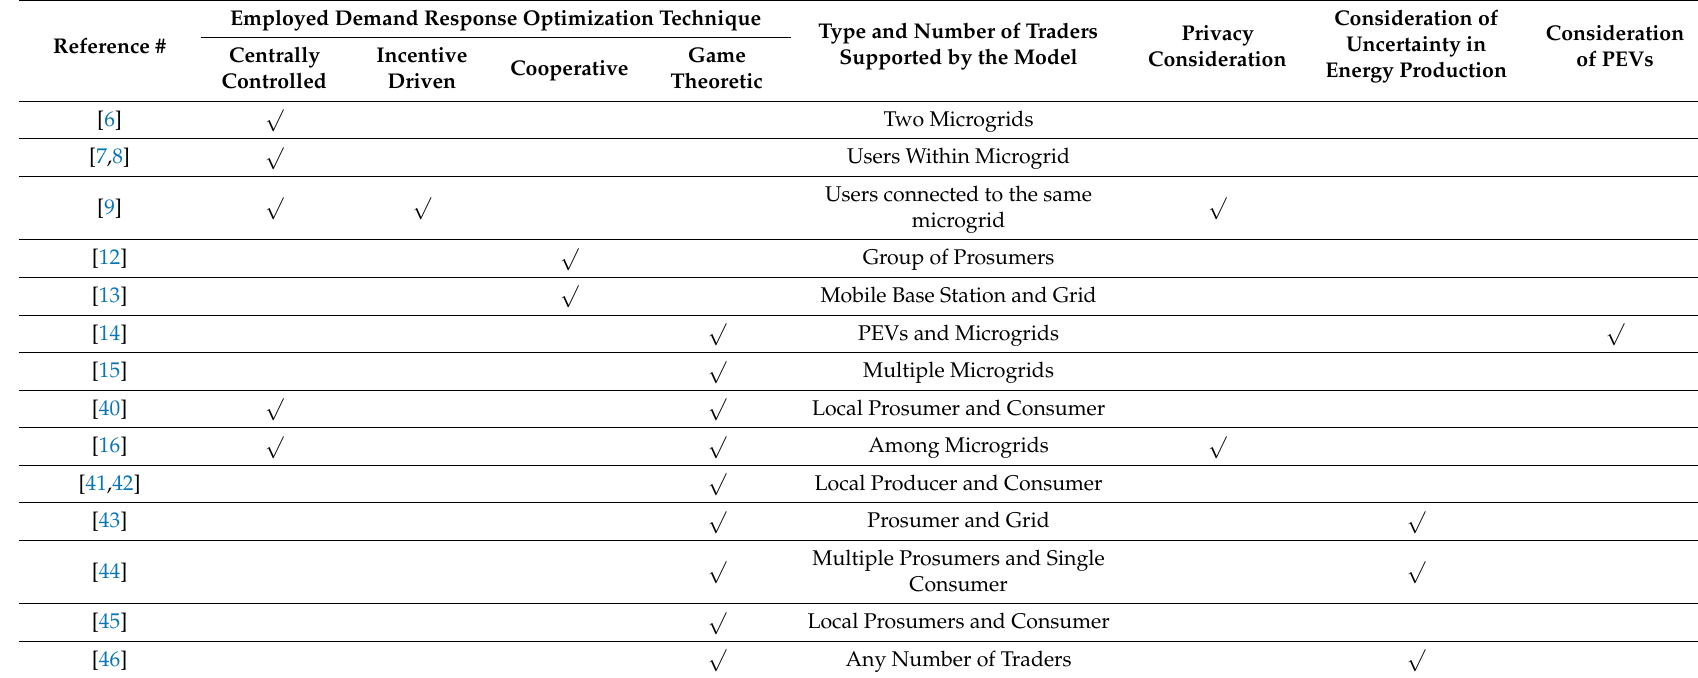
Table 1. Summary of Demand Response Optimization